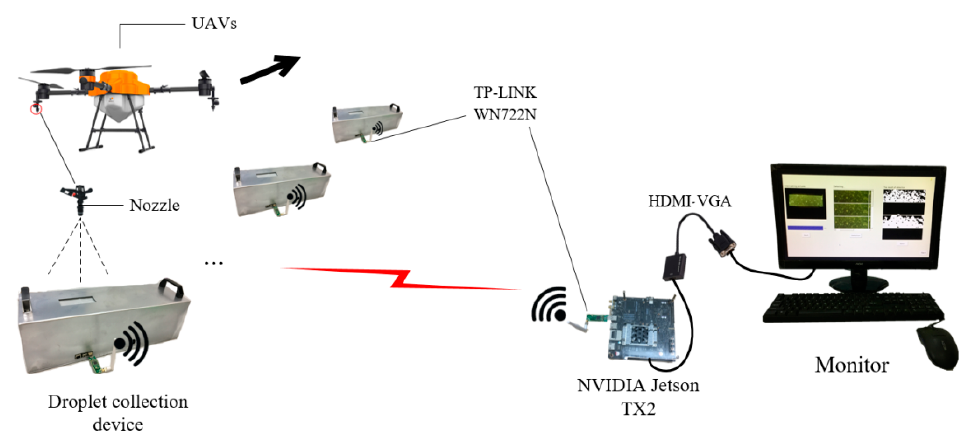
Figure 2. Scene structure of system work. UAV: Unmanned Aerial Vehicle Figure 1. collection device structure. ( a ) Internal structure; ( b ) External structure. Note: 1. Released